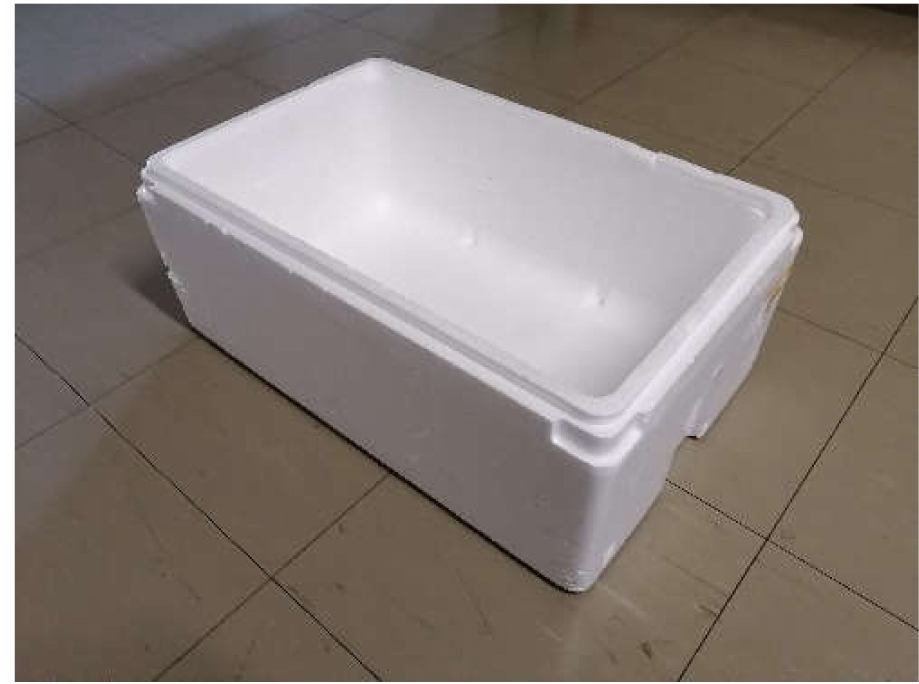
Figure 1. Styrofoam fish container, commonly known as a fish